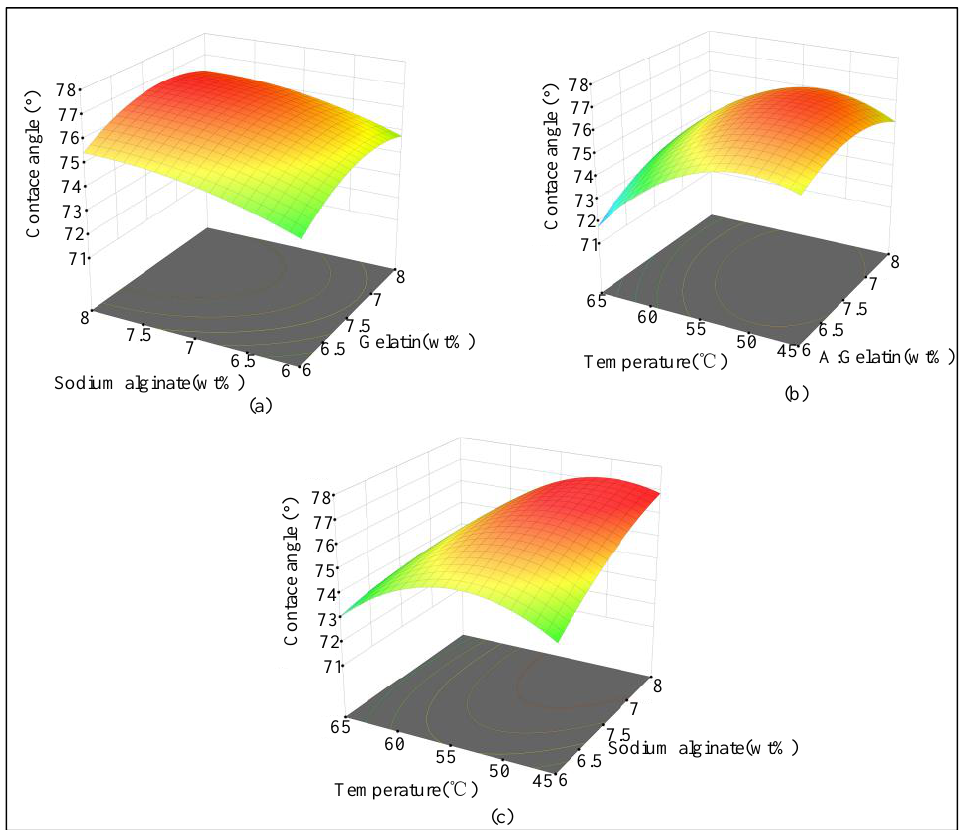
Figure 3. Influence of factor interaction on the contact angle ( n = 16). ( a ) Effects of alginate concentra- tion and gelatin concentration on the contact angle of the mixed hydrogel. ( b ) Effects of temperature and gelatin concentration on the contact angle of the mixed hydrogels. ( c ) Effects of temperature and alginate concentration on the contact angles of the mixed hydrogels. Temperature/alginate had the greatest effect on the contact angle, followed by temperature/gelatin, and, finally, gelatin/alginate. It can be seen from Figure 4 that when the printed line spacing is relatively large, the line width is stable, and the line spacing can be clearly separated between the lines. As the line spacing decreases, the integration degree between the lines and the line spacing gradually increases, and the printed line will be deeply integrated into a closed